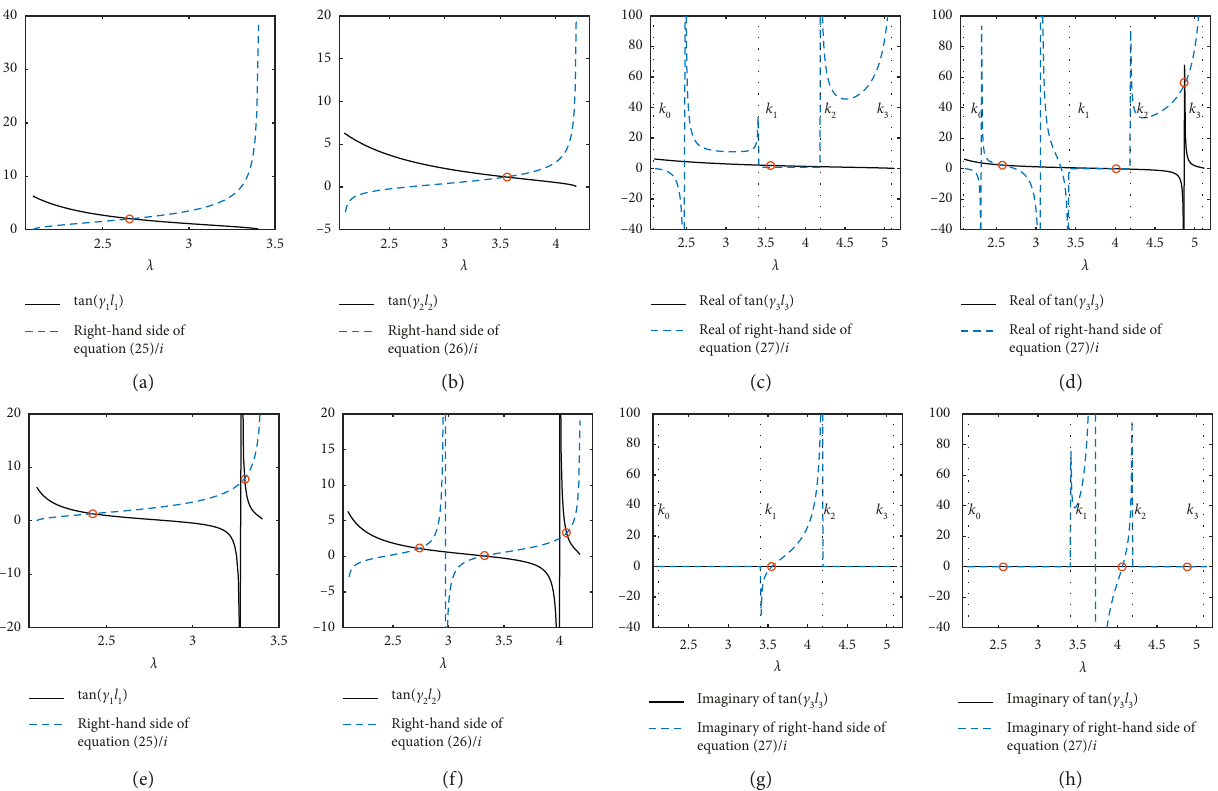
Figure 5: Graphical approach for root finding in evaluations of poles by equations from (25)–(27) at the operating frequency f � 100MHz for the electromagnetic field due to a vertical dipole over a perfect conductor coated by multilayered lossless dielectrics, with (a) N � 3, k l � 0 . 45 π ; (b) N � 4, k i i k